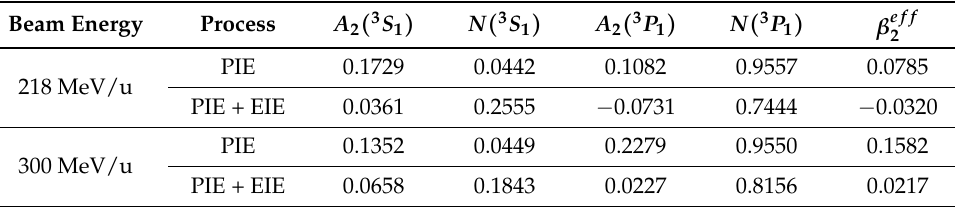
Table 2. Theoretical values for the alignment parameters A 2 , the relative populations N , and the resulting effective anisotropy parameters β ef f for [ 1 s 1/2 ,2 s 1/2 ] 3 S 1 and [ 1 s 1/2 ,2 p 1/2 ] 3 P 1 states 2 contributing to the K α 2 line. For details see